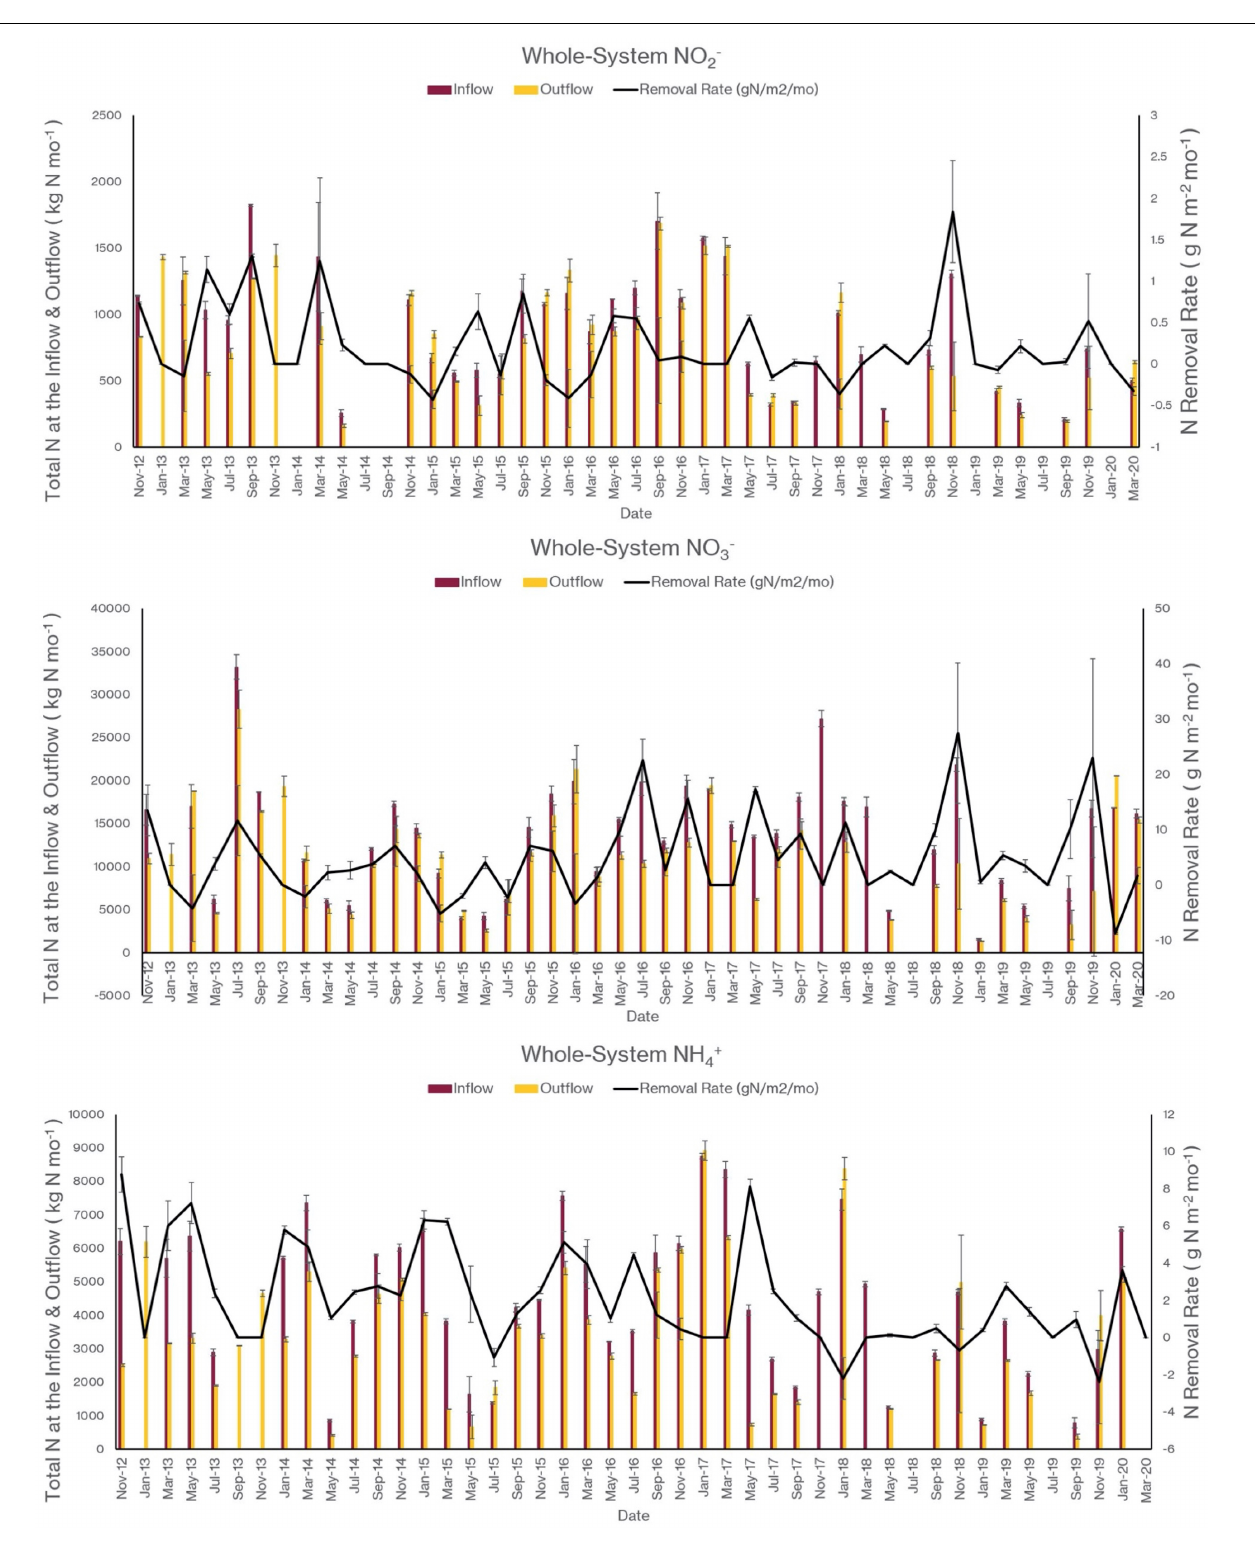
FIGURE 4 | Monthly nitrogen flux into (inflow) and out of (outflow) the 42 ha CTW and the N removal rates at the whole-system scale for (top) NO 2 - , (middle) NO 3 - , and (bottom) NH 4 + (modified from Treese et al.,